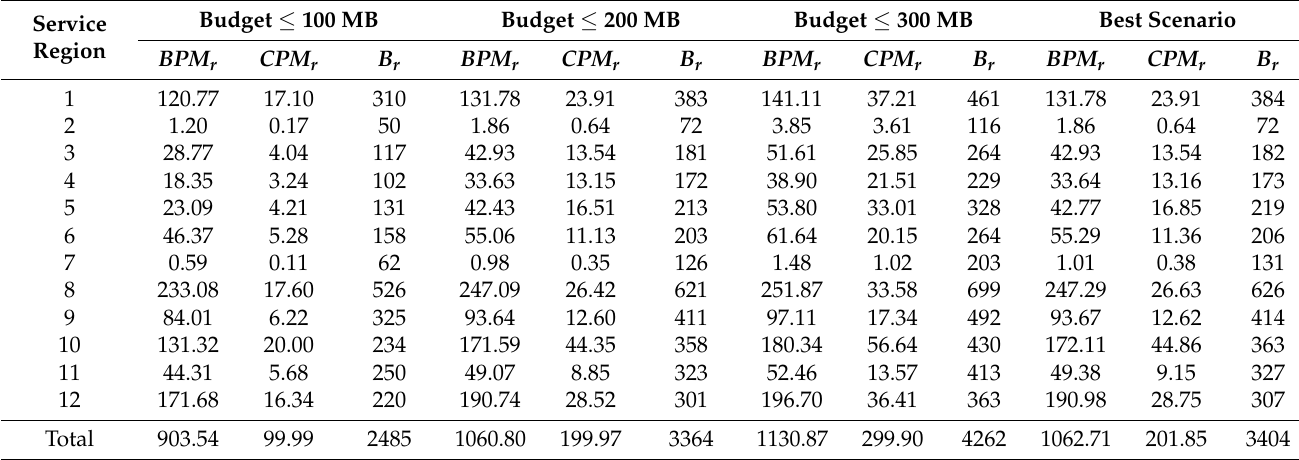
Preventive maintenance plans obtained from the BCR prioritization and the pro- posed method.